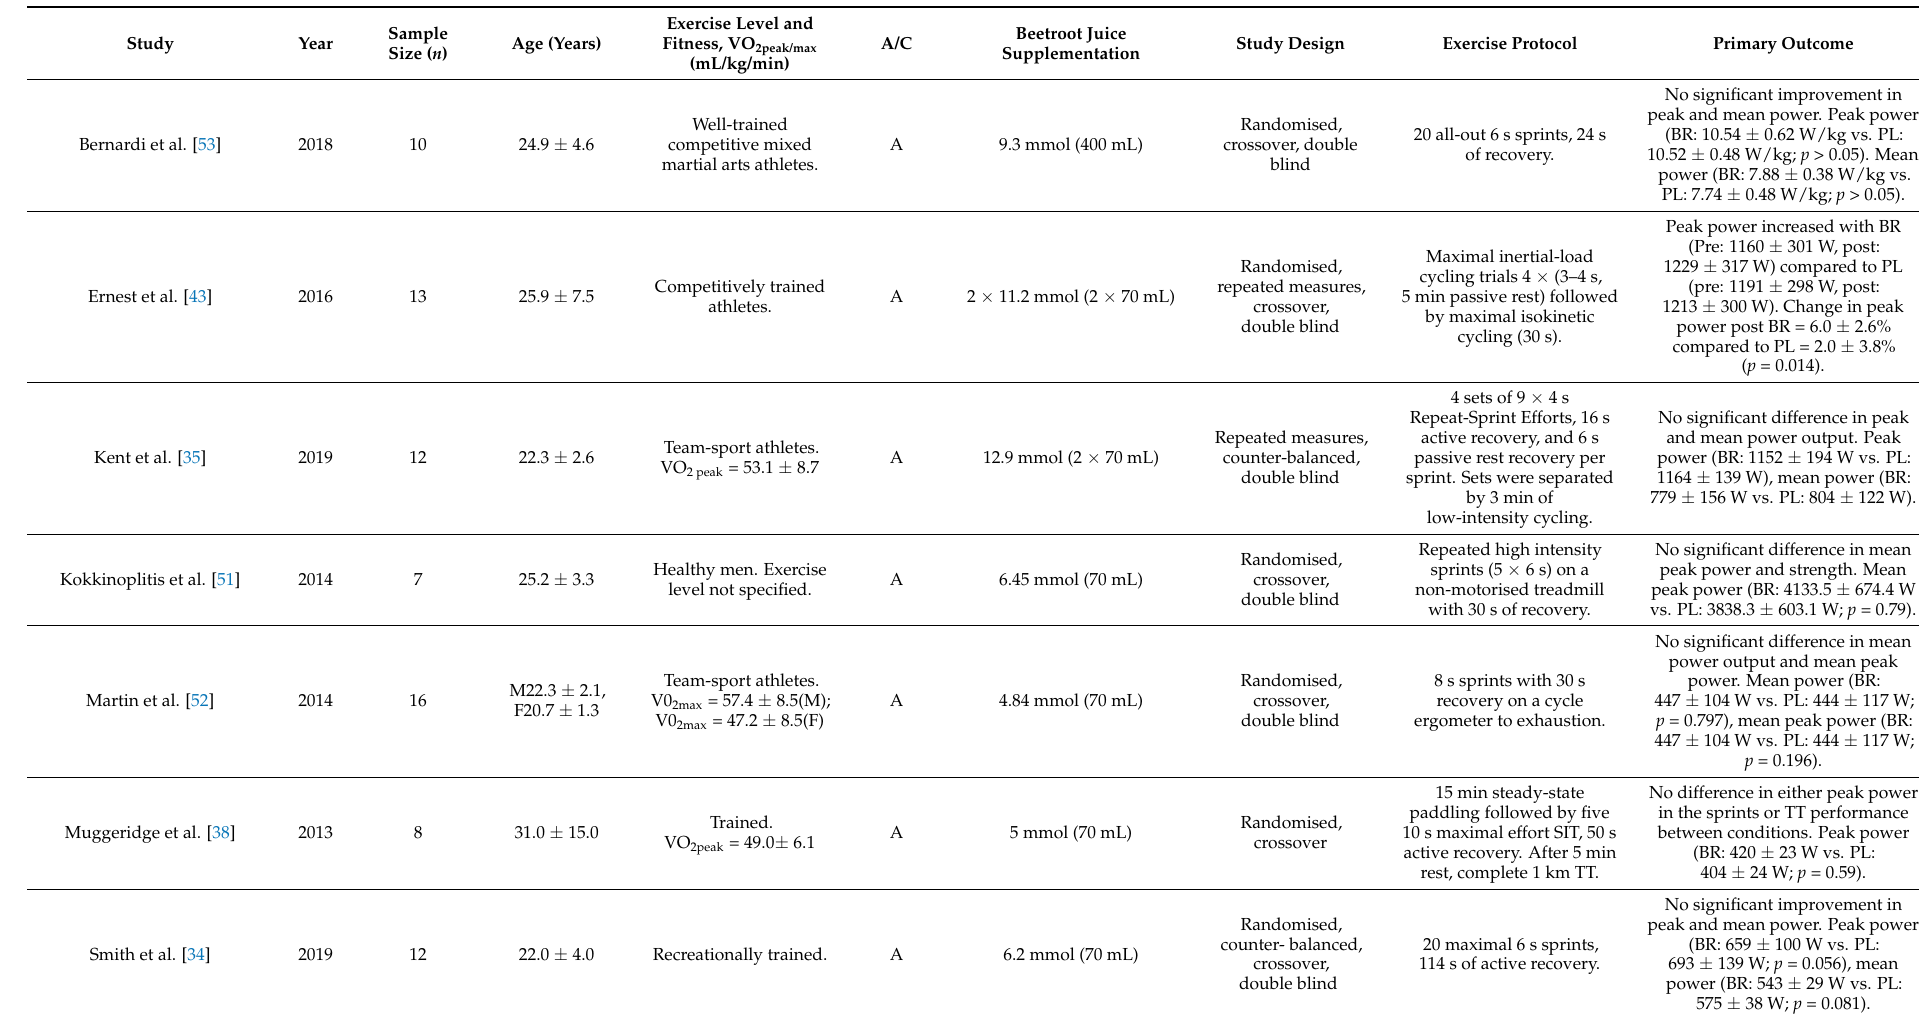
Table 1. Summary of the included studies assessing the effect of dietary beetroot supplementation on HIIT and SIT performance.